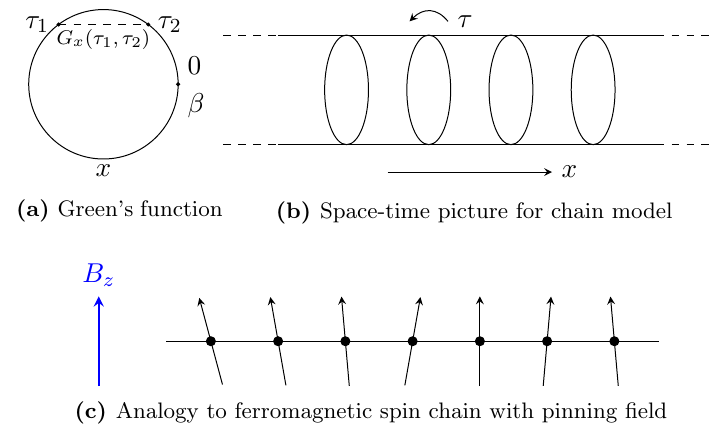
Figure 4. (a) Green’s function G x ( (cid:28) 1 ; (cid:28) 2 ) is a function of two imaginary time variables, each de(cid:12)ned on the imaginary time circle. It transforms covariantly under the reparametrization (cid:12)eld f x 2 Di(cid:11)( S 1 ). (b) The space-time picture for the chain model. The Schwinger-Dyson equation at conformal limit has global reparametrization symmetry, but the conformal solution sponta- neously breaks Di(cid:11)( S 1 ) to PSL 2 ( R ). Moreover, the UV term (cid:0) i! in (3.11) breaks the emergent reparametrization and lifts the Goldstone modes to pseudo-Goldstone modes. (c) The situation in the SYK chain model is similar to a ferromagnetic spin chain with a small pinning (cid:12)eld, where